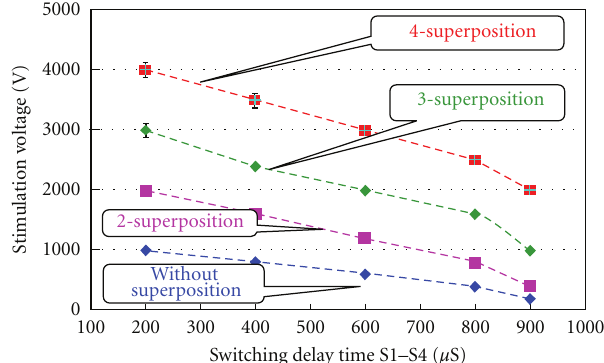
Figure 9: Relationship between the superposition and stimulation